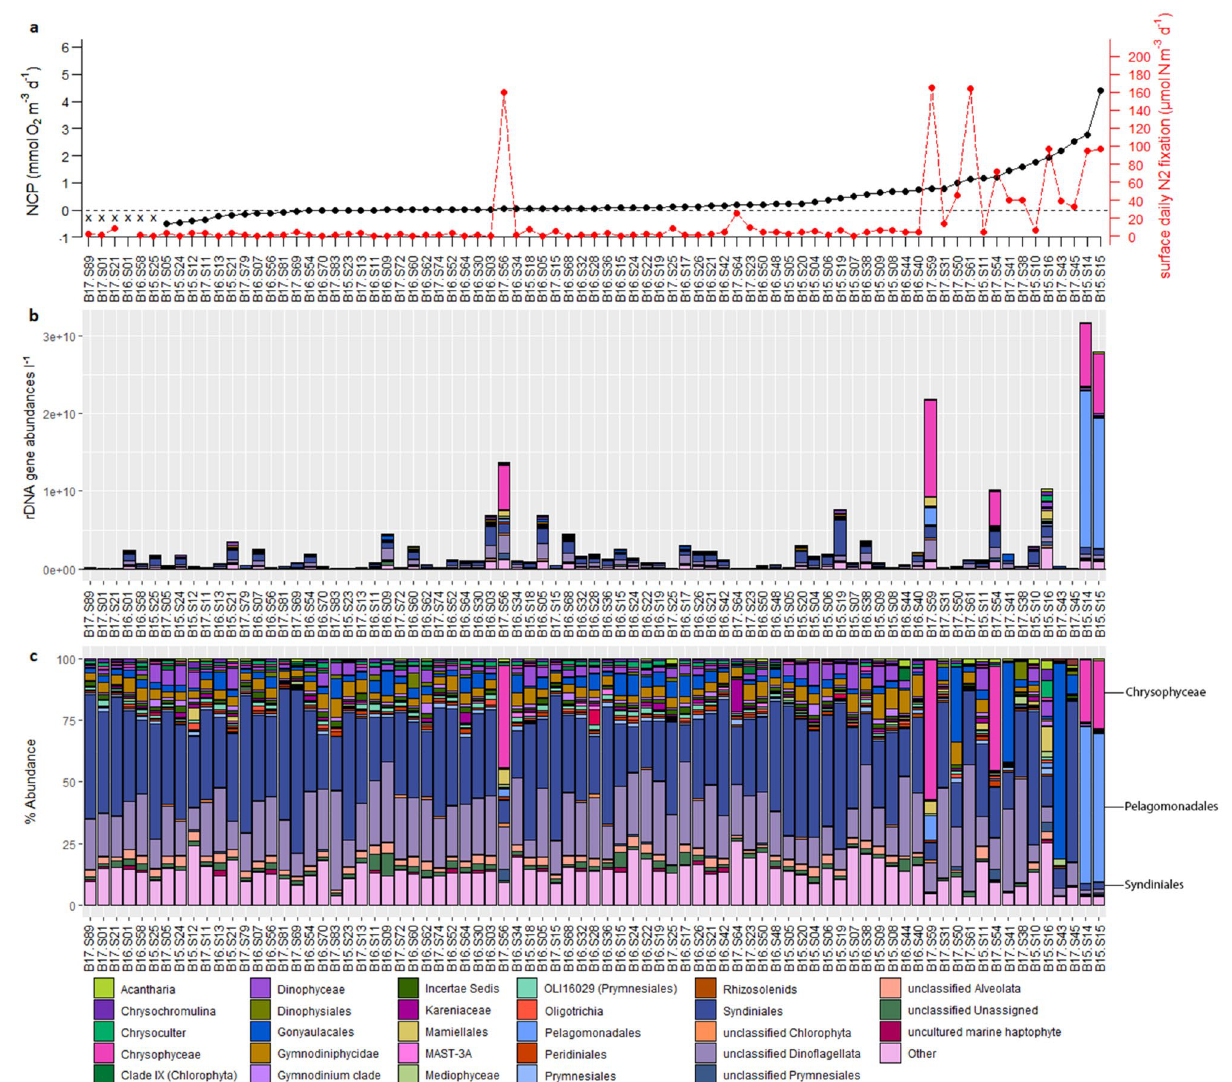
Figure 3. Eukaryotic community structure. ( a) N 2 fixation rates (red) and NCP rates (black) measured at each sampling site 22,36,37 , with sites ranked from left-to-right in order of increasing NCP. Sites at which NCP measurements were not collected are grouped on the far left and denoted with x-marks. Taxa are organized in alphabetical order from top to bottom, following the order outlined in the legend. ( b) Bar plot of 18S eukaryotic taxonomy represented at the 5th taxonomic rank using quantitative rDNA gene abundances l -1 . ( c) Bar plot of 18S eukaryotic taxonomy at the 5th taxonomic rank using relative abundances. Note that Aureococcus anophagefferens fall within the order Pelagomonadales, and make up the overwhelming majority of pelagophytes in the sample set. Figure created in R 3.5.2 (https ://www.r-proje